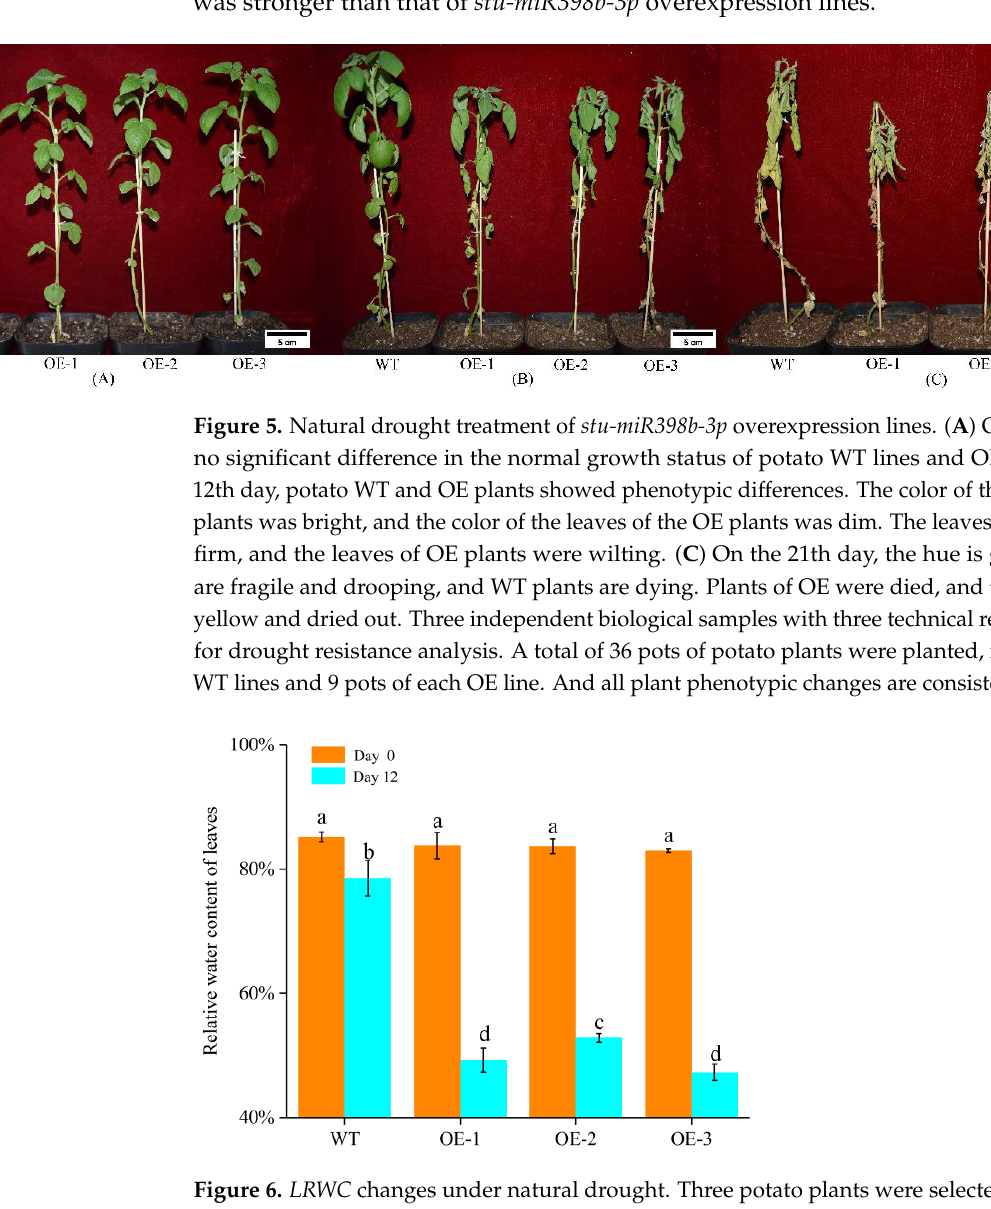
Figure 6. LRWC changes under natural drought. Three potato plants were selected from each strain, and three groups of repeats were taken from each plant, and the 3–5 leaves were selected from the top to the bottom. Each column represents the mean values ± SE ( n = 3). The letters indicate significant difference according to one-way ANOVA corrected by Dunnett ( p < 0.05).